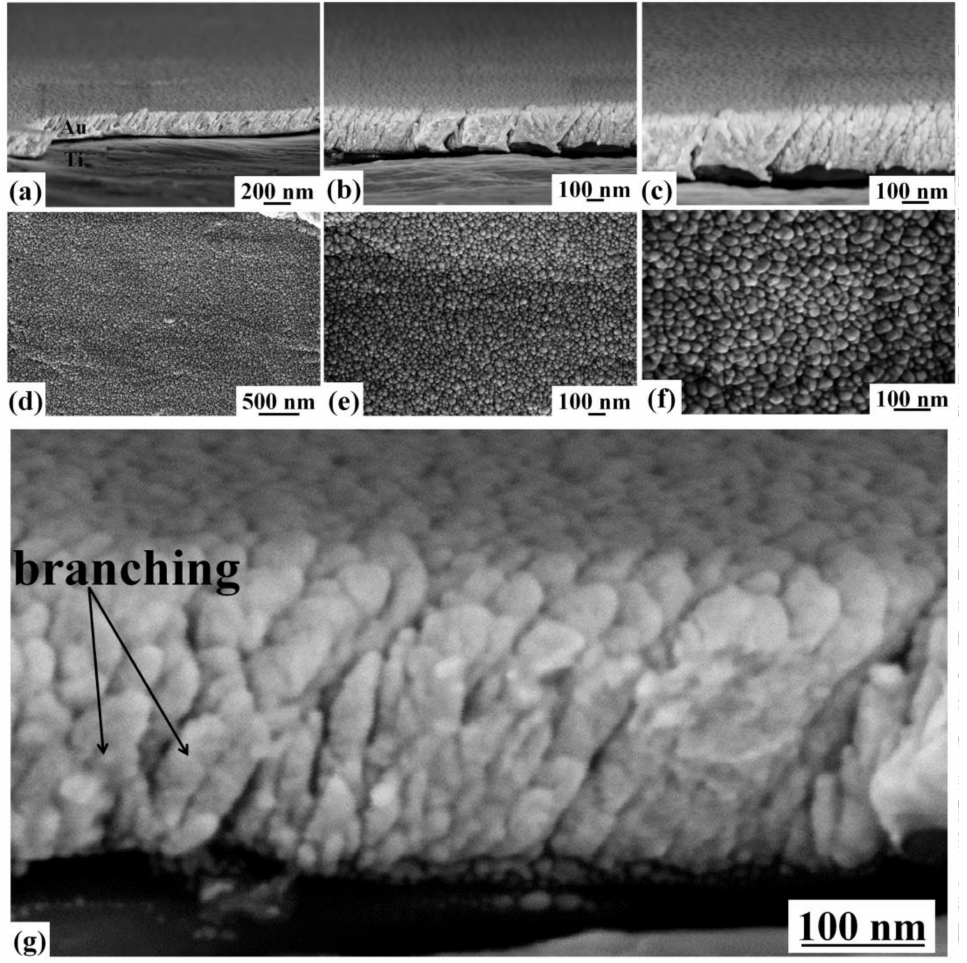
Figure 5. Cross-section (( a – c ), with magnification increase from ( a ) to ( c )) and plan-view (( d – f ), with magnification increase from ( d ) to ( f )) SEM images of the thicker (230 nm-thick) Au film deposited at θ = 48 ◦ on Ti (sample B2). ( g ) Reports a much higher magnification cross-view image to better highlight a branching phenomenon of the Au